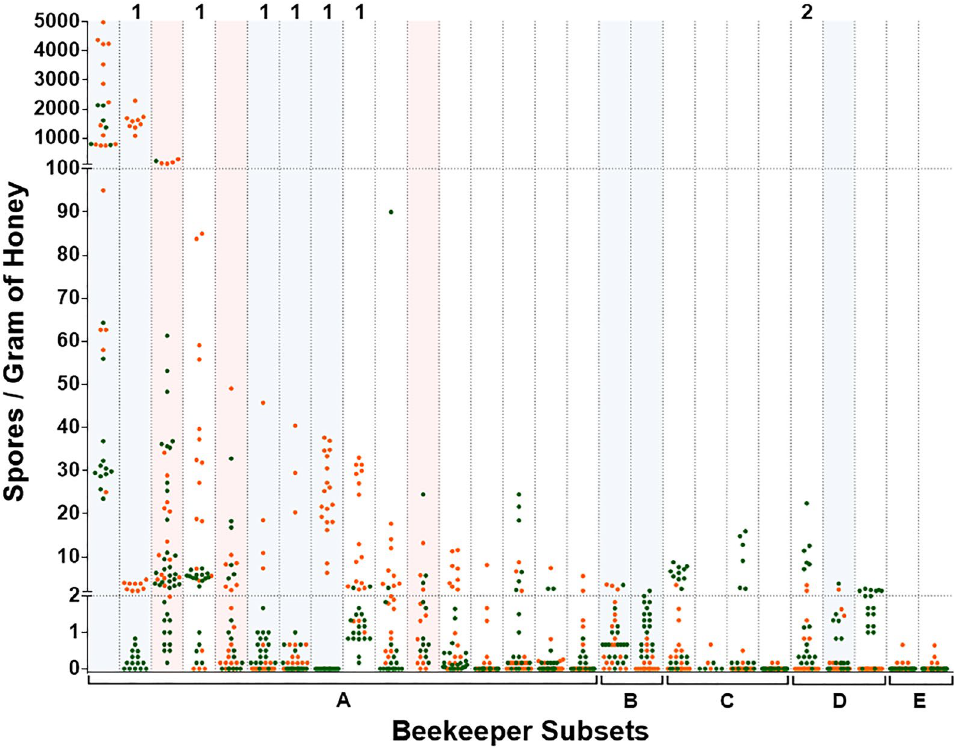
Figure 3. Paenibacillus larvae spore concentrations in extracted honey of large-scale (L) beekeepers sampled in both 2019 and 2020. Orange dots indicate spore concentrations in honey samples collected in 2019 and green dots for 2020. L beekeepers are separated from one another by vertical dashed lines. Beekeepers highlighted in light red are those that reported AFB in 2021. Beekeepers highlighted in light blue are those that reported a historical occurrence of AFB within the previous four years (2017–2020). L beekeepers were selected for repeat (2020) sampling by meeting one of the following subset criteria: A = maximum 2019 spore